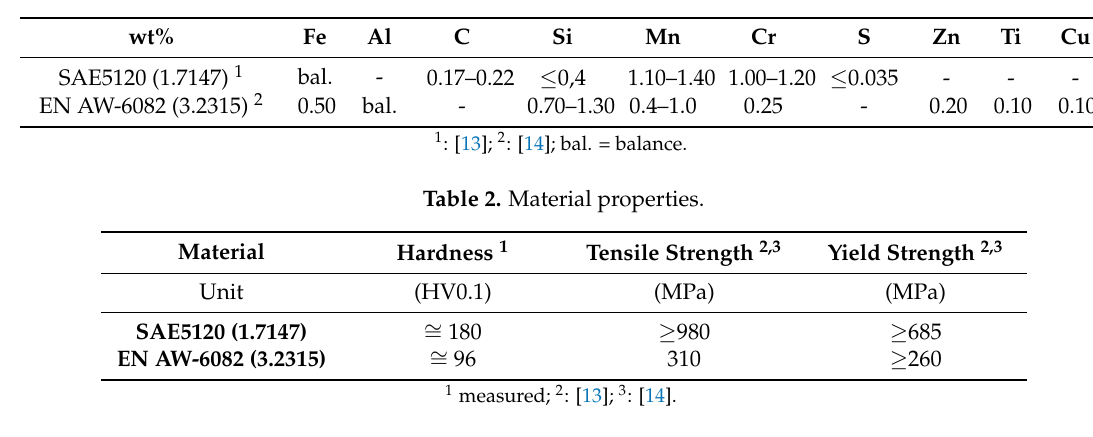
Table 1. Chemical compositions.